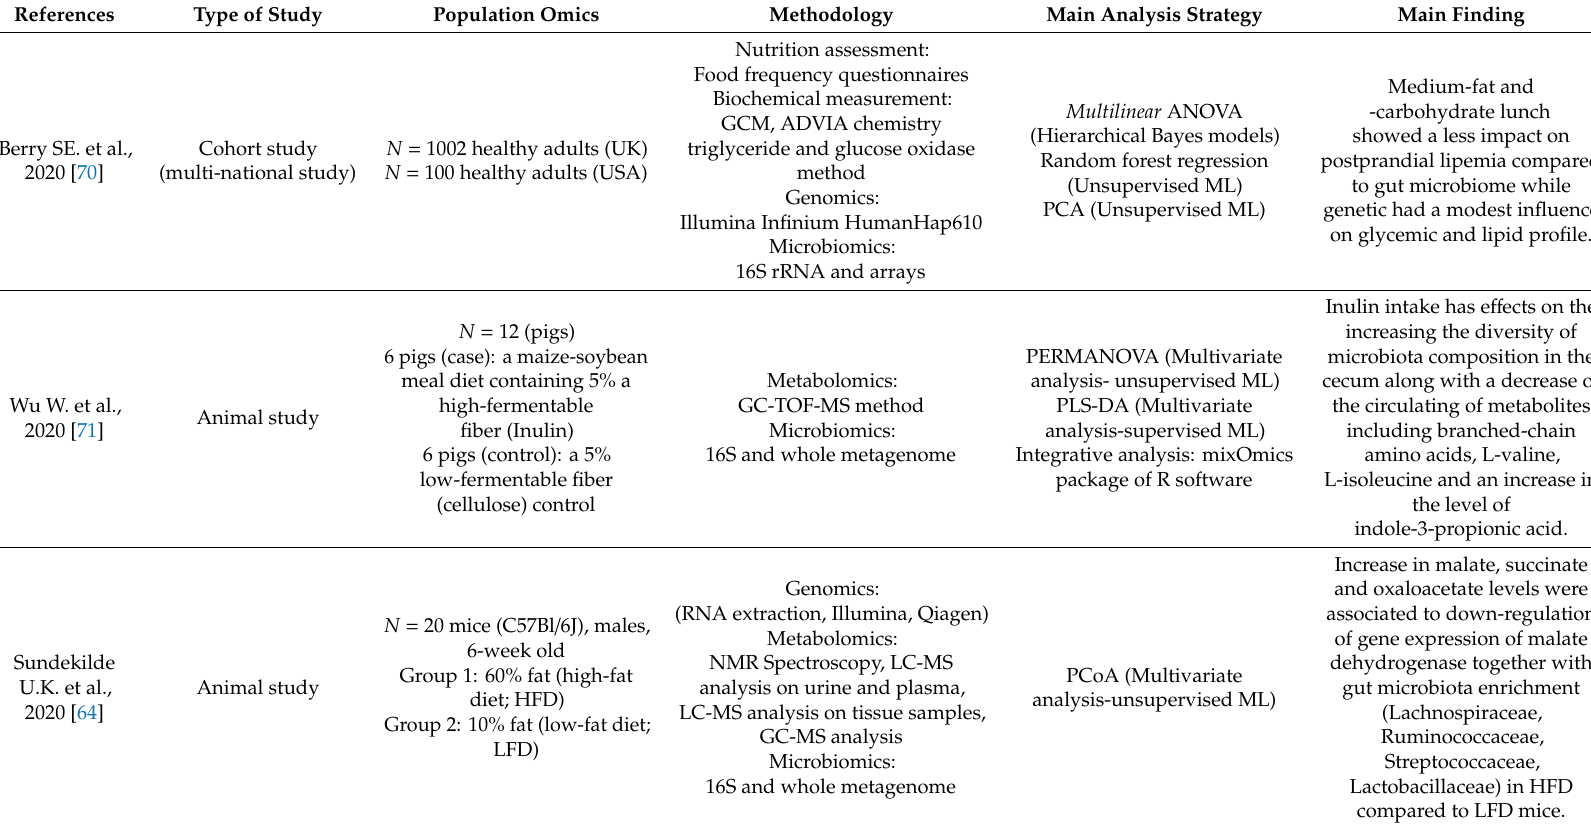
Table 1. Human and animal studies using multi-OMICs approaches for the investigation of dietary intake on health and disease